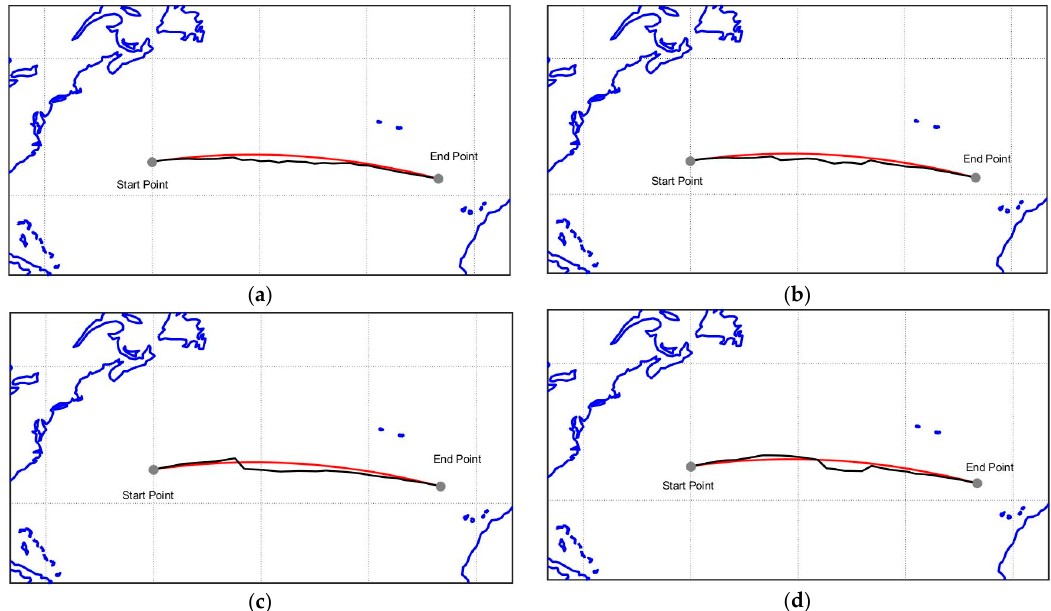
Figure 6. Minimum distance (great circle) and optimal route detection, F N = 0.18: ( a ) Case 1; ( b ) Case 2; ( c ) Case 3; ( d ) Case 4.